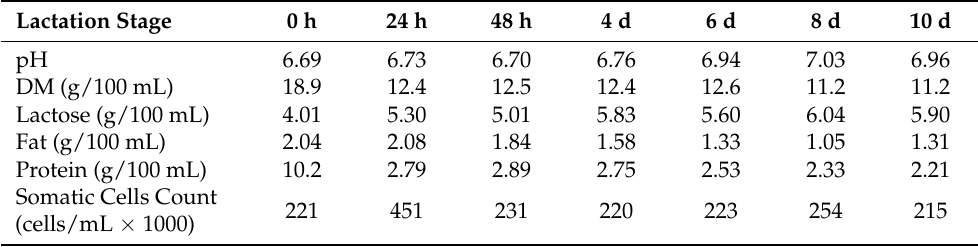
Table 3. DC chemical and physical composition during the first ten day of lactation. Lactation